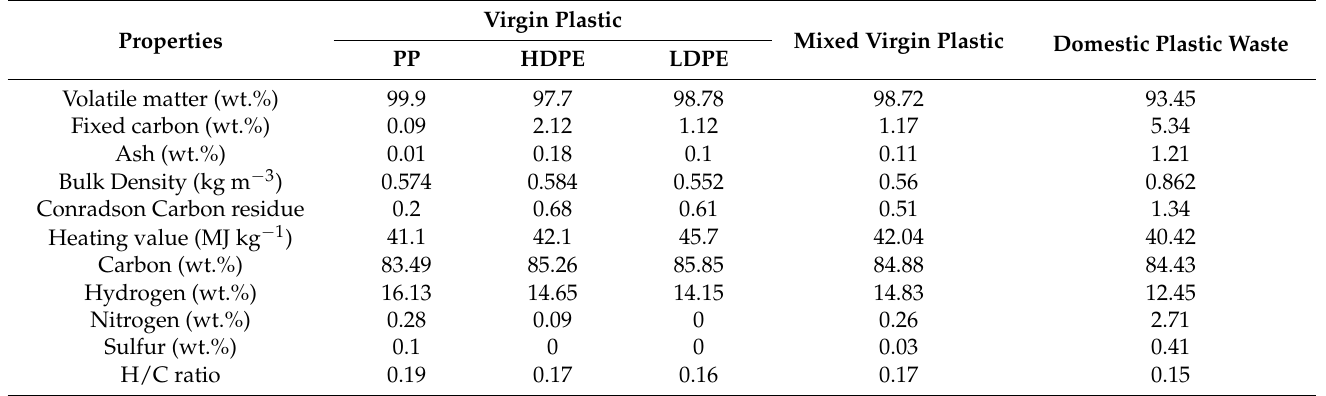
Table 1. Characteristic properties of different plastic feedstocks (dry